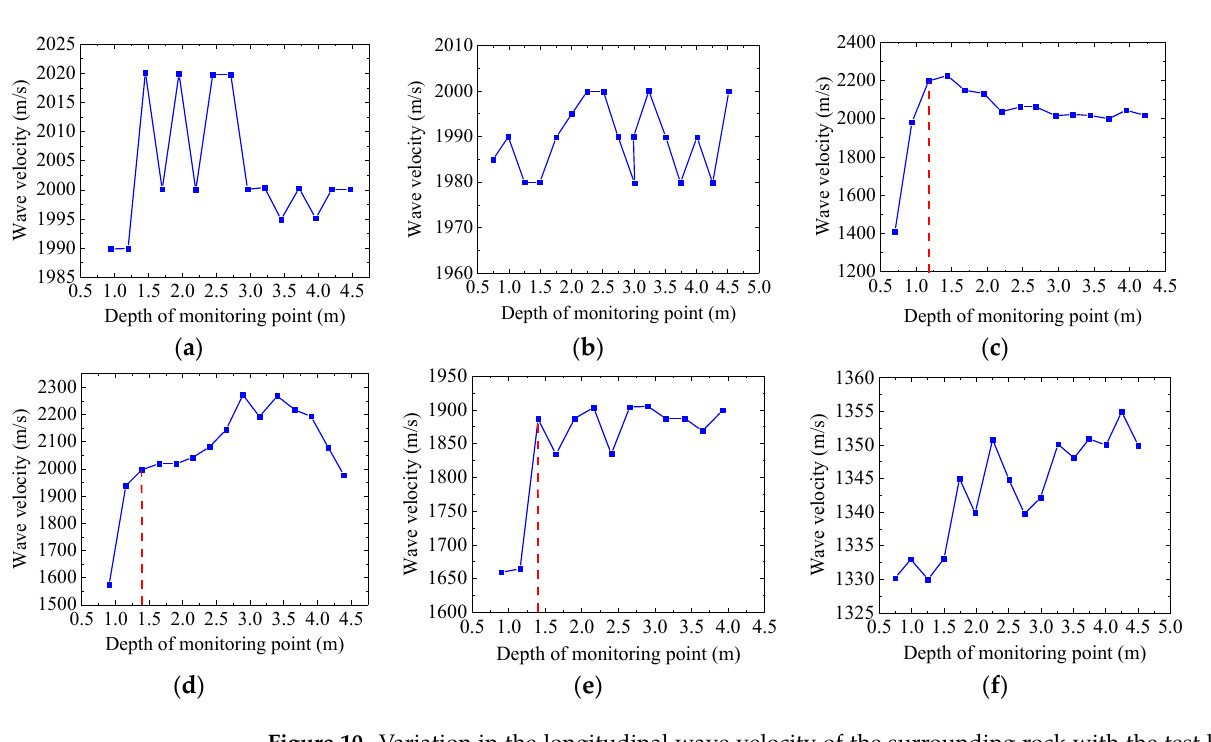
Figure 9. Variation in the longitudinal wave velocity of the surrounding rock with the test hole depth during tunnel nonelectric detonator blasting excavation. ( a ) R1, ( b ) R2, ( c ) R3, ( d ) L1, ( e ) L2, and ( f ) L3.